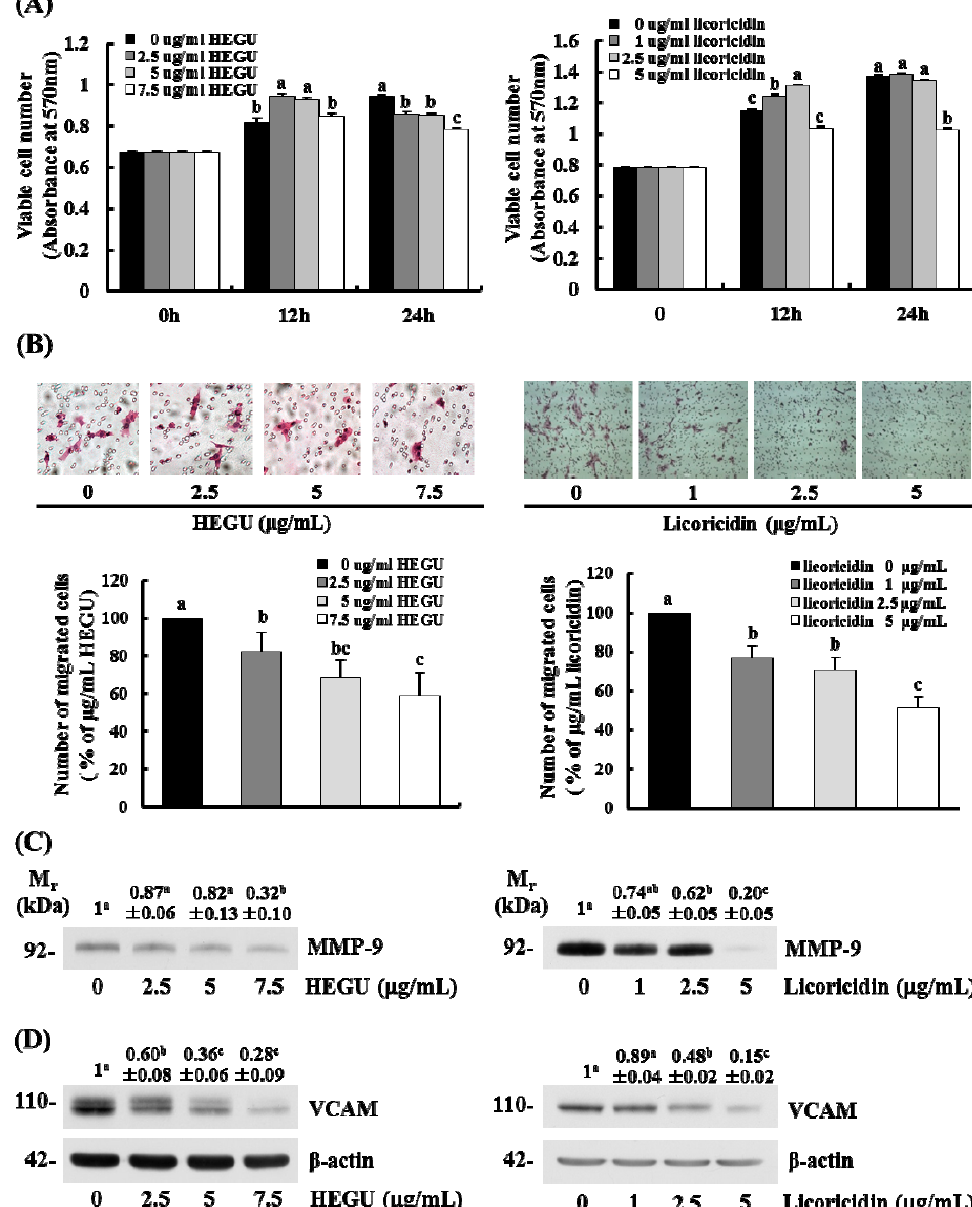
Figure 5. HEGU and licoricidin decrease the migration of 4T1 cells. 4T1 cells were treated as described in Materials and Methods. ( A ) Cell viability was tested using the MTT assay; ( B ) Transwell migration assays were conducted with serum-deprived 4T1 cells. Photographs of H&E stained cells are shown (×100) ( upper panel). The number of migrated cells were counted and expressed as a percentage of the untreated control cells ( lower panel). Each bar represents the mean ± SEM of 3 independent experiments; ( C ) 18 h-conditioned media and ( D ) total cell lysates were analyzed by Western blotting. The volume of media loaded onto the gel was adjusted to achieve equivalent protein concentrations. Representative chemiluminescent detection of the immunoblots (from 3 independent experiments). The relative abundance of each band was quantified and the control level was set at 1. The adjusted value (mean ± SEM, n = 3) of each band is shown above each lane in the blot. Means without a common letter differ, p < 0.05.